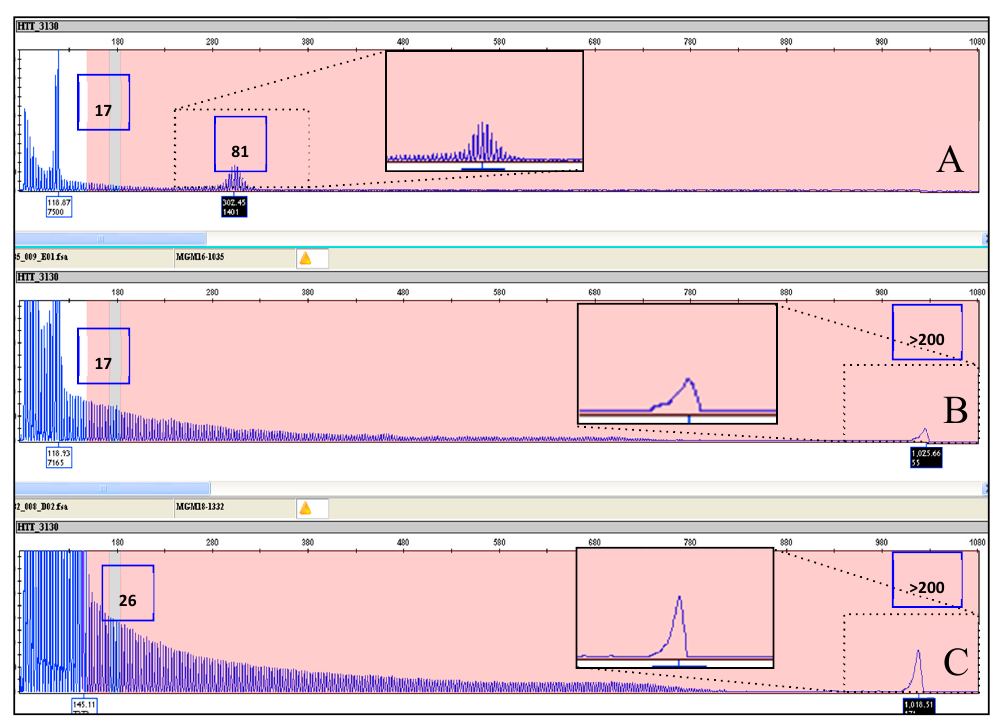
Figure 4. Electropherogram results for samples with unusually large CAG expansions. ( A ) Electable 16. showing alleles of 17/81 CAG repeats and a continuous stuttering after the first prominent peak. ( B , C ) show sample MGM16-1035 and sample MGM18-1332, respectively, with the presence of a pile-up peak at the end of the run representing the high CAG expansion of 200 repeats (zoom of pile-up in B , C ).